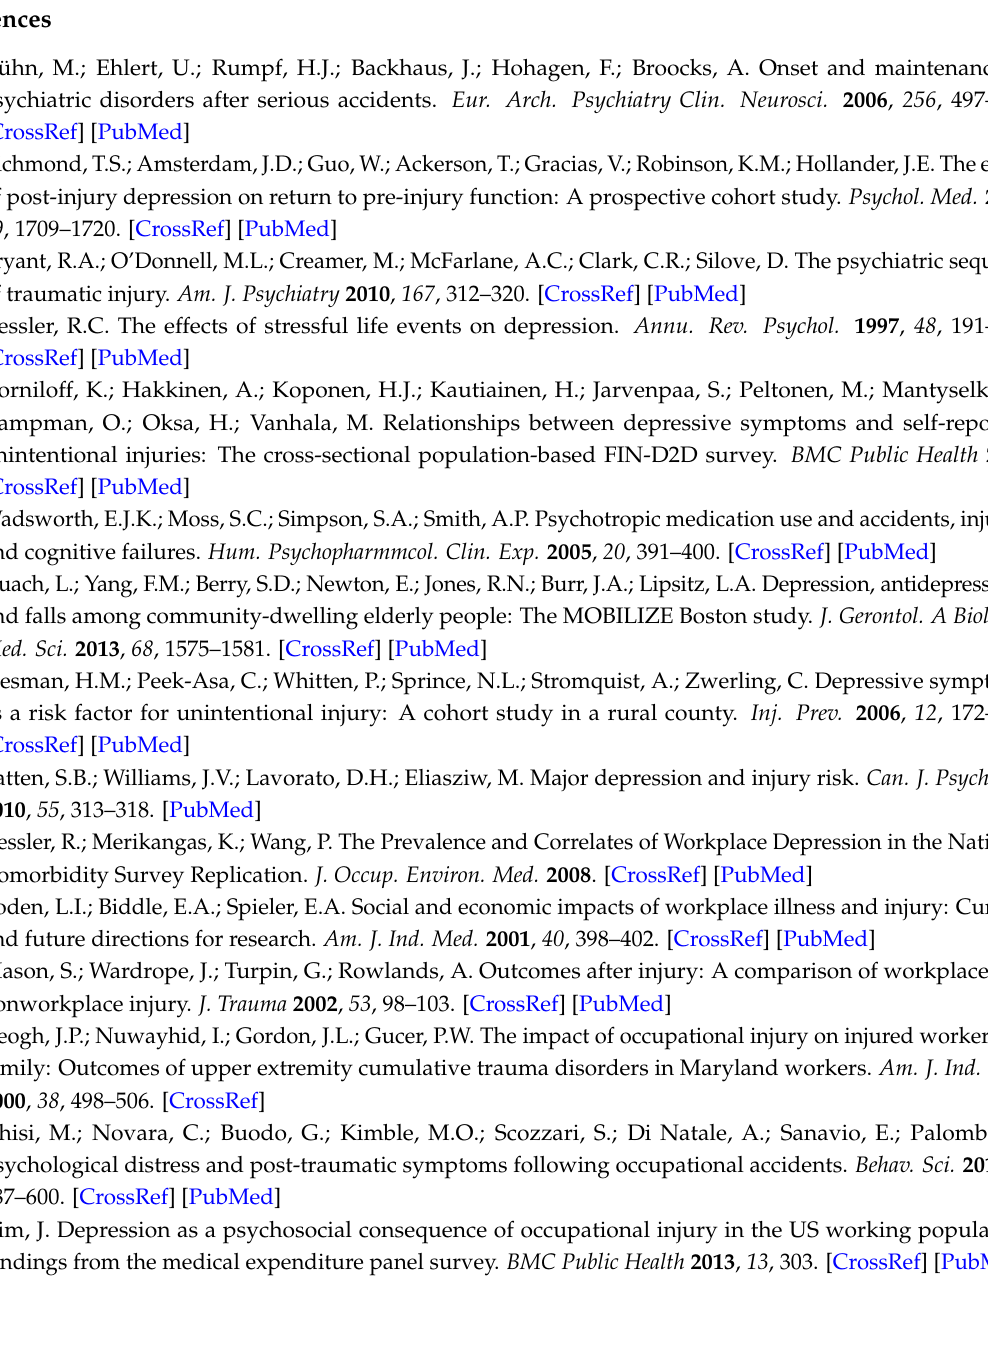
Table S1: Association between occupational injury and depression in the MEPS population after excluding participants with low mental health